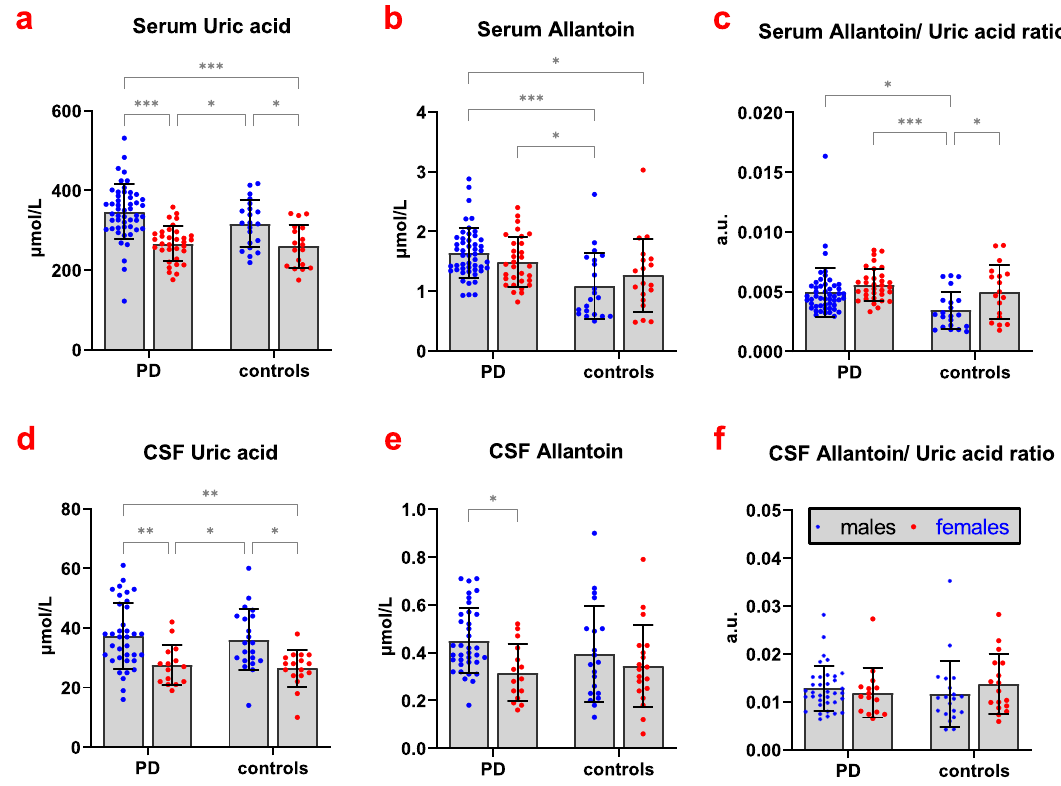
Fig. 1 Dot graphs of serum and CSF UA, allantoin, and allantoin/UA ratio (Bars with whiskers represent means and standard deviations). a Serum UA, b Serum allantoin, c Serum allantoin/UA ratio, d CSF UA, e CSF allantoin, f CSF allantoin/UA